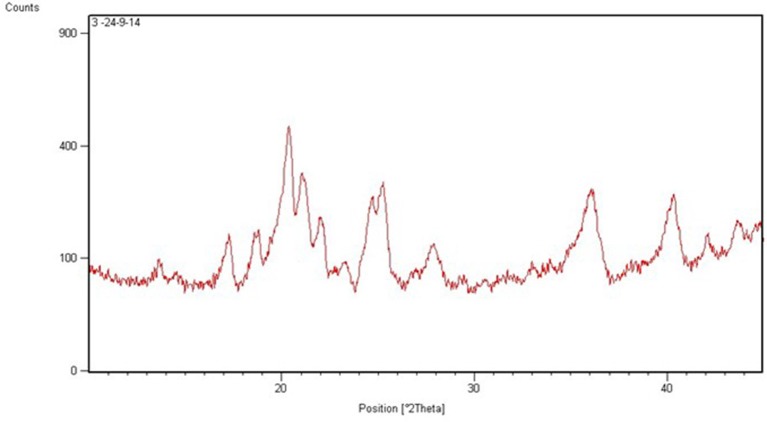
XRD spectra of CA-PLGA nanoparticle.